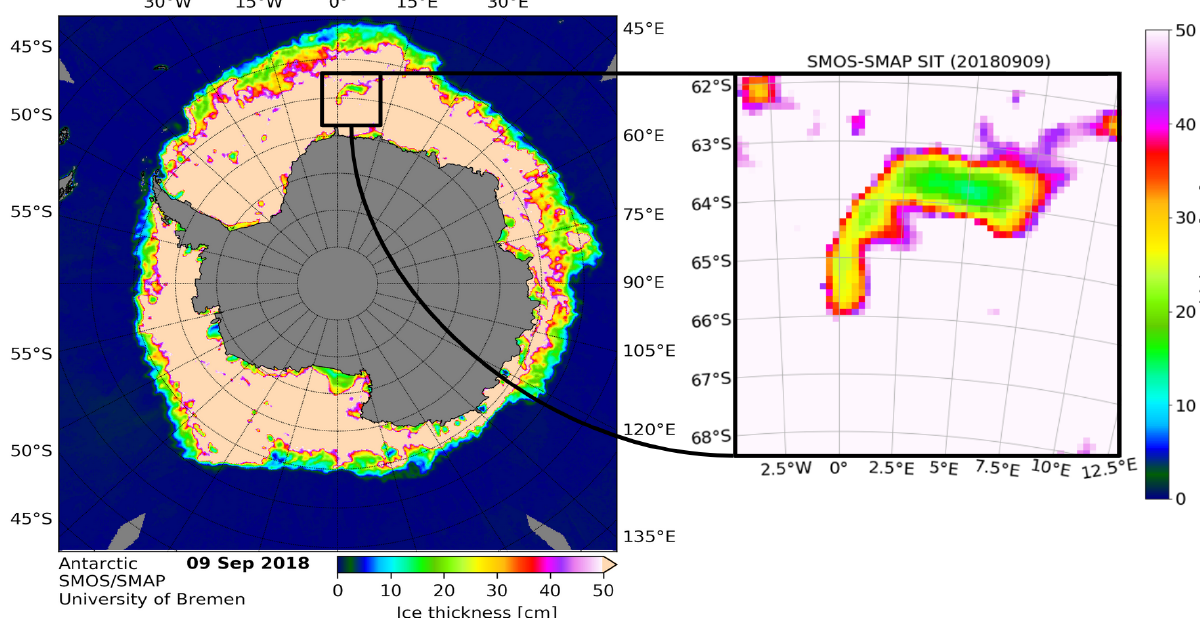
Figure 1. Left: SMOS–SMAP apparent sea ice thickness (ASIT) retrieval for the sea ice zone around Antarctica from 9 September 2018. The segment contained in the black square depicts sea ice above Maud Rise (66 ◦ S, 3 ◦ E). Right: the zoomed-in local SMOS–SMAP ASIT of the outlined region which serves as the boundaries of all time series generated in this